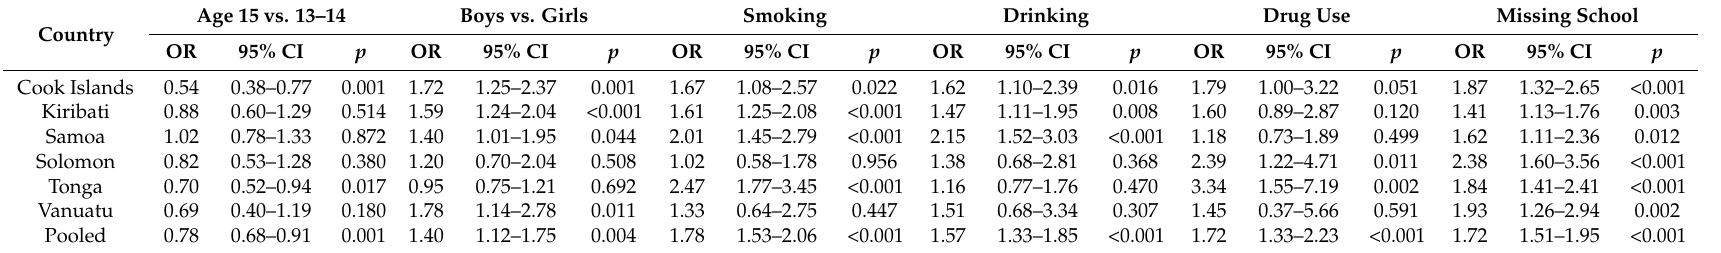
Table 4. Influence of smoking, drinking, drug use and missing school on risk of physical fight in young adolescents in 6 Western Pacific countries. Age 15 vs. 13–14 Boys vs. Country